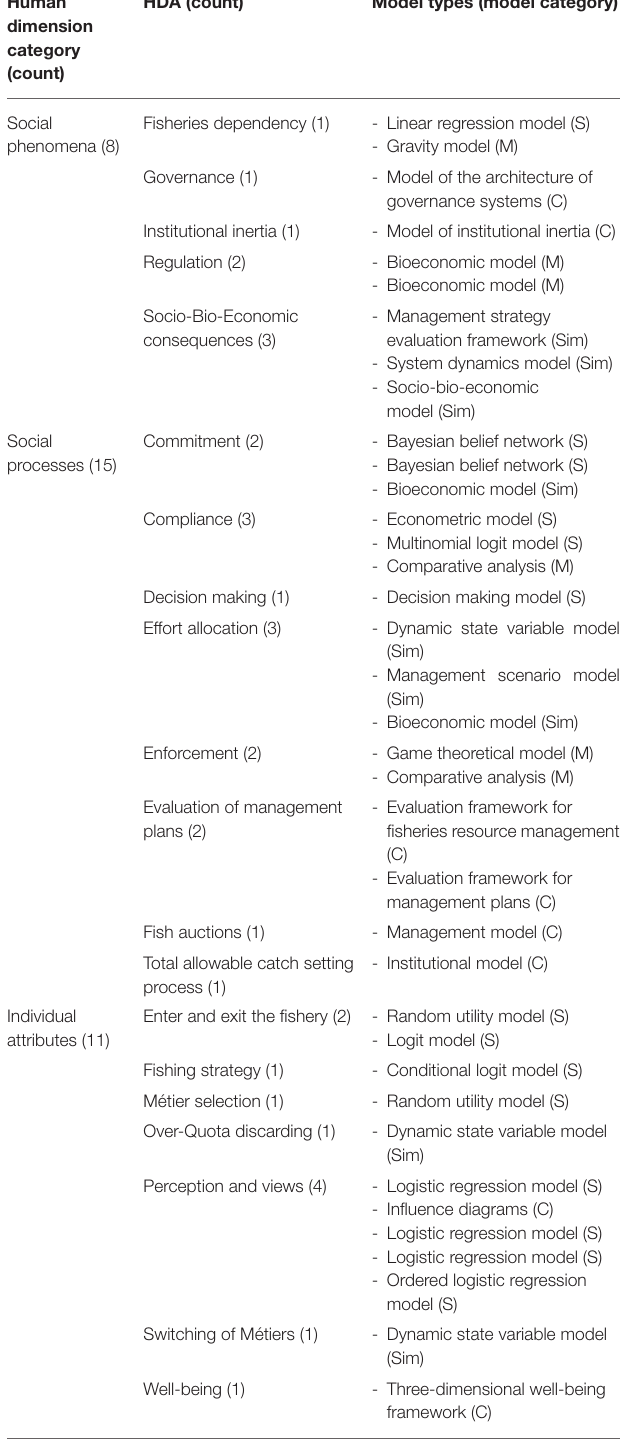
TABLE 4 | List of human dimension aspect (HDAs) identified within the publications, mapped against the general human dimension topics of study proposed by Bennett et al. (2017) and the model types.